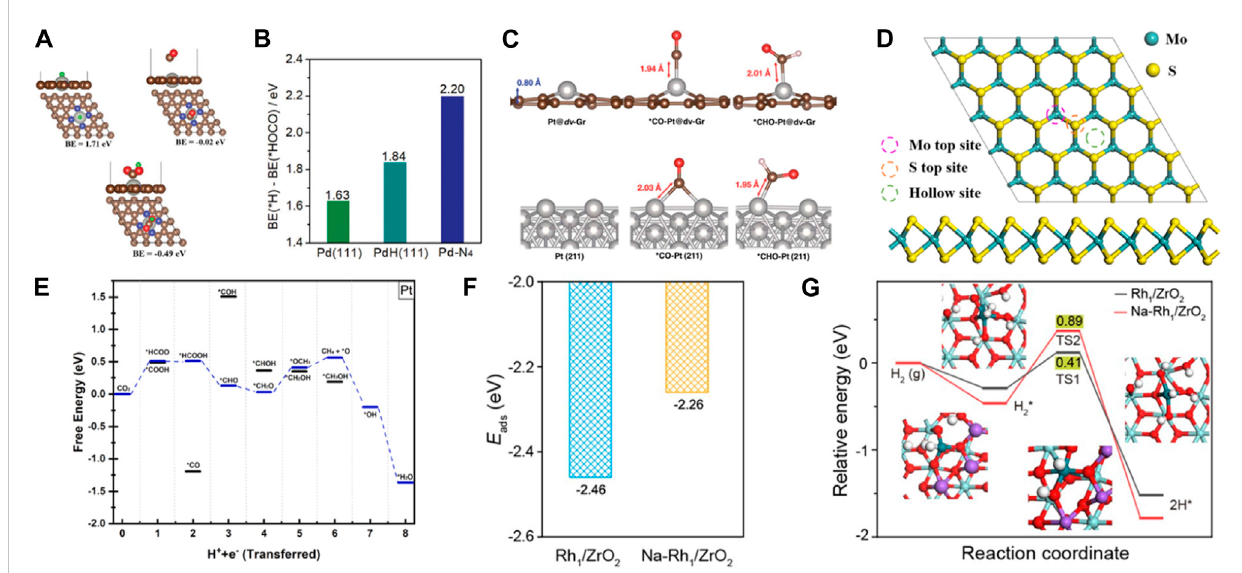
FIGURE 4 (A) The optimized structures and calculated binding energies of *H, *CO, and *HOCO adsorbed on a Pd-N 4 catalytic by DFT calculations. Gray, Pd; brown, C; blue, N; red, O; green, H. (B) The binding energies difference of *H and *HOCO on Pd(111), PdH(111), and Pd-N 4 ( fi gure used with permission from Chen et al., 2020a). (C) The optimized con fi gurations of *CO and *CHO adsorbed on Pt@dv-Gr and Pt(211) ( fi gure used with permission from Jung et al., 2017). (D) The top views and side views of the MoS 2 nanolayers. (E) Free energy diagrams for the CO 2 RR on Pt@MoS 2 . (Figure used with permission from Zhao et al., 2022a). (F) The adsorption energies of CO on Rh 1 /ZrO 2 and Na-Rh 1 /ZrO 2 . (Figure used with permission from Lu et al., 2022). (G) Theenergypro fi lesofH 2 reactionandthestructuresoftheoptimizedintermediatesonRh 1 /ZrO 2 andNa-Rh 1 /ZrO 2 .(Figureusedwithpermissionfrom Lu et al.,